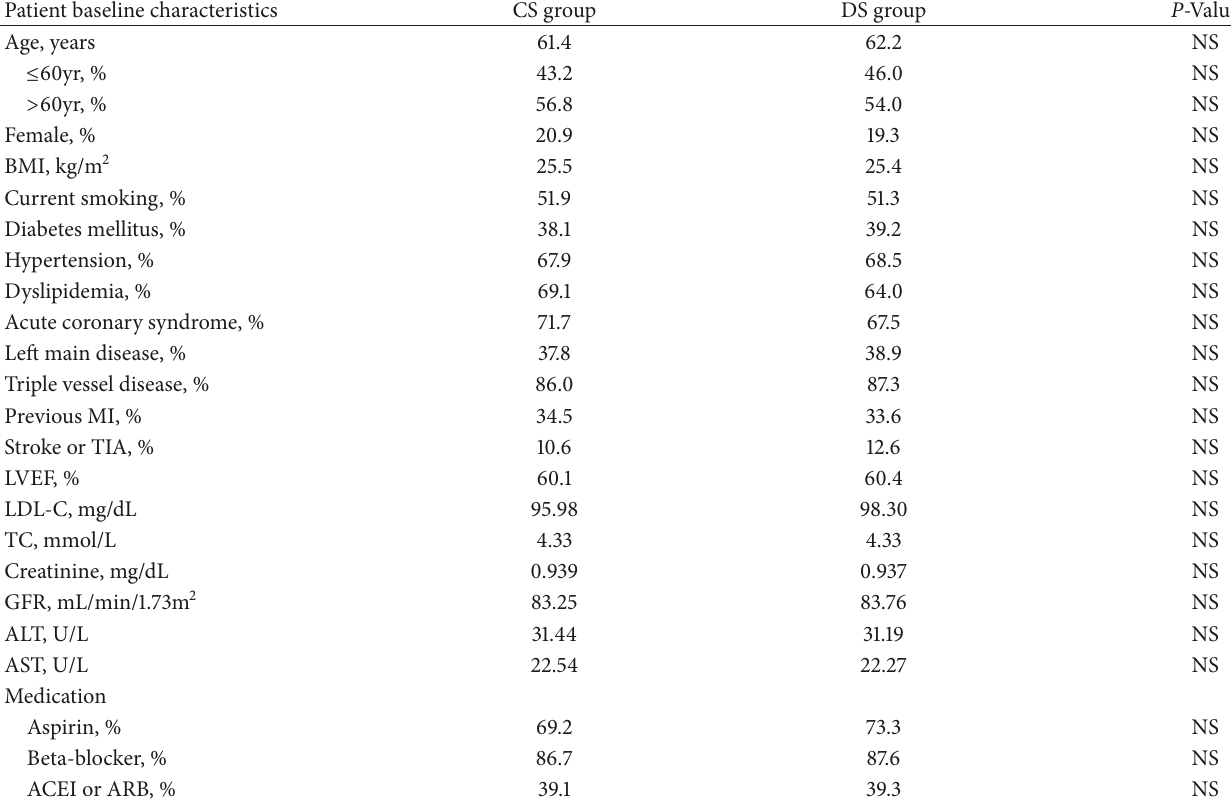
Table 2: Baseline characteristics of overall patient after IPW Adjustment.